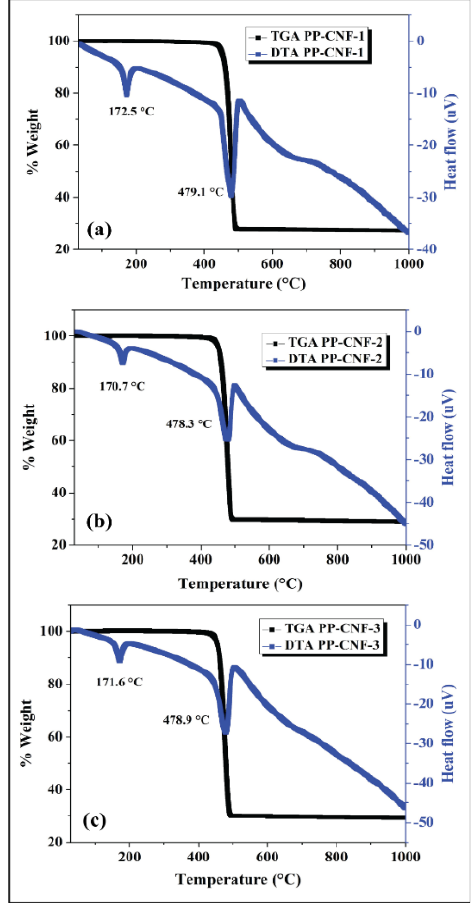
Figure 10. TGA and DTA curve of ( a ) PP-CNF-1, ( b ) PP-CNF-2 and ( c ) PP-CNF-3 nanocomposite.